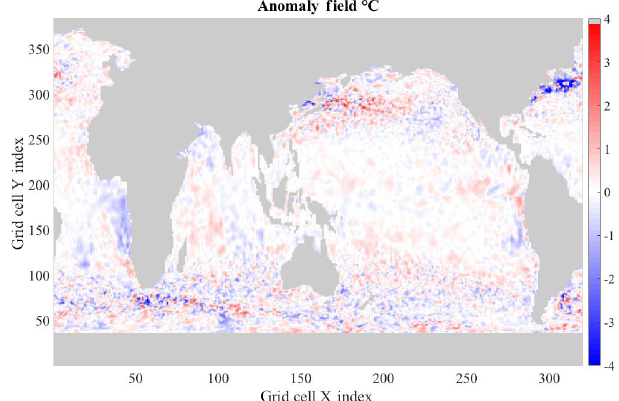
Figure 2. Example map of an anomaly field for one initial condi-